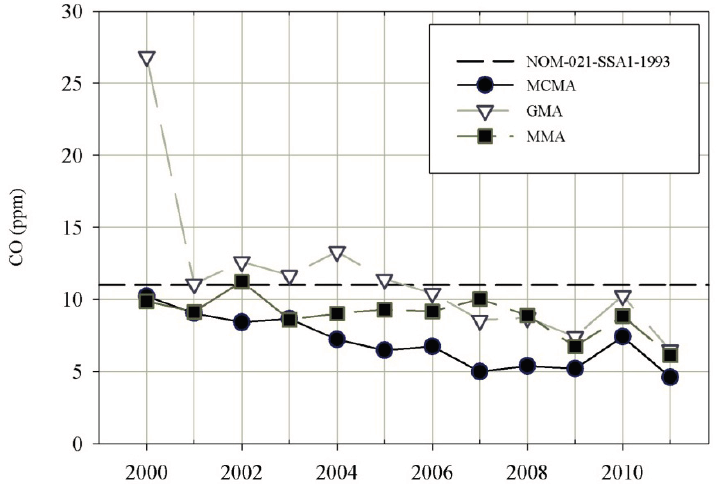
Figure 6. Maximum values of 8-h moving-average CO concentrations in the three Mexican metropolitan areas. The dashed horizontal line indicates the MPL in